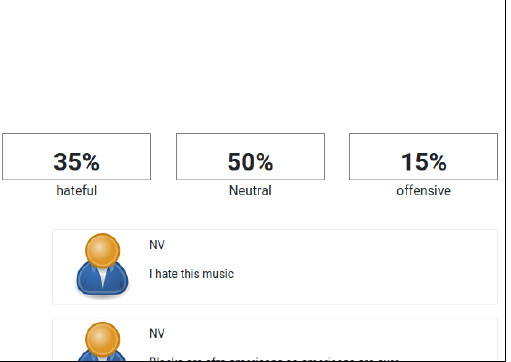
Figure 5. Real time monitoring of content and scoring page based on percentage if hateful content is present.